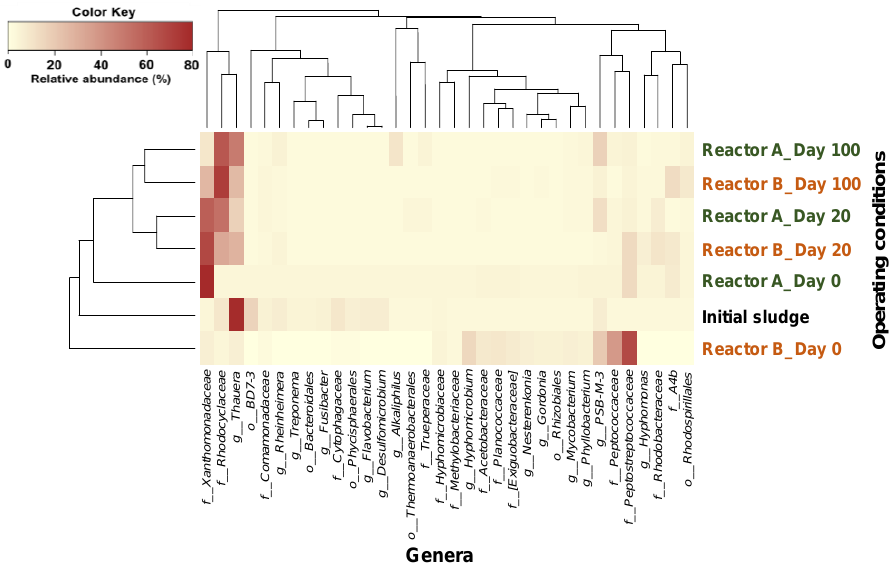
Figure 7. Heatmap of microbial community compositions (relative abundance in percentage) in sludge samples collected from reactors A and B under various operation times. Table 3. Relative abundance of bacteria (%) under different operation